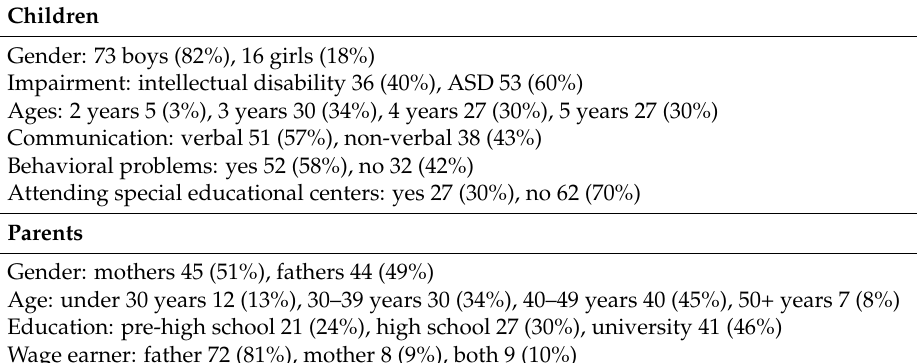
Table 2. Demographic information of parents and children with autism spectrum disorders (ASD) and intellectual disability (ID) ( N =